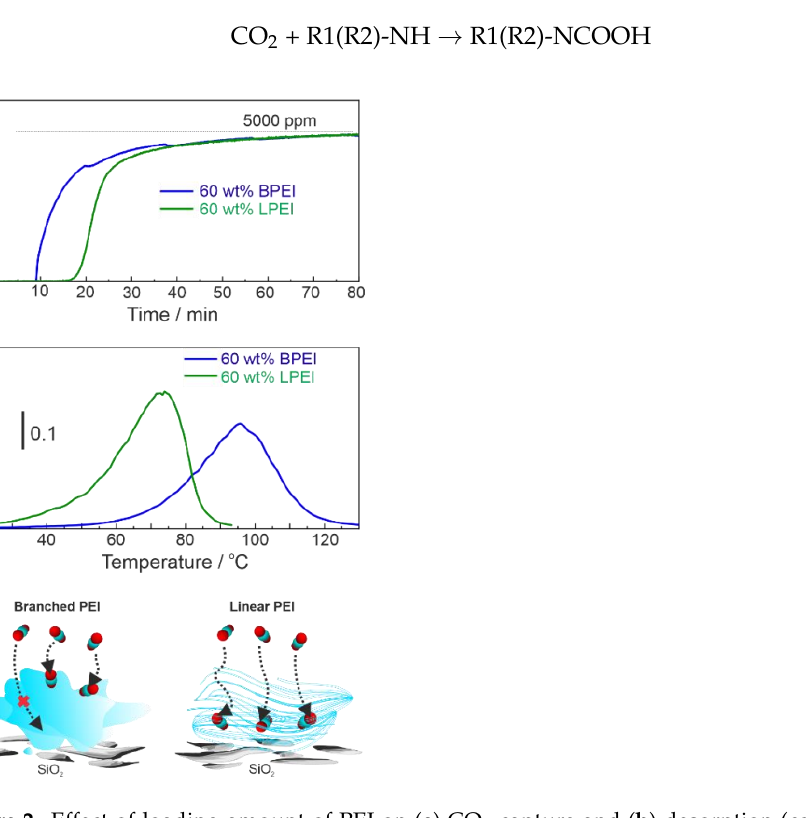
Figure 2. Effect of loading amount of PEI on ( a ) CO 2 capture and ( b ) desorption (conditions are identical to the experiments in Figure 1 with H 2 O). ( c ) Schematic illustration of CO 2